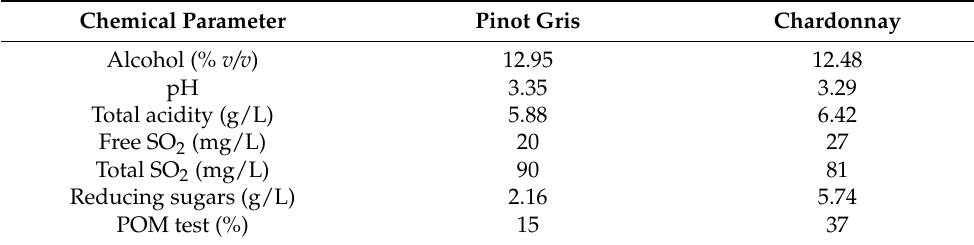
Table 1. Chemical properties of Pinot Gris and Chardonnay.